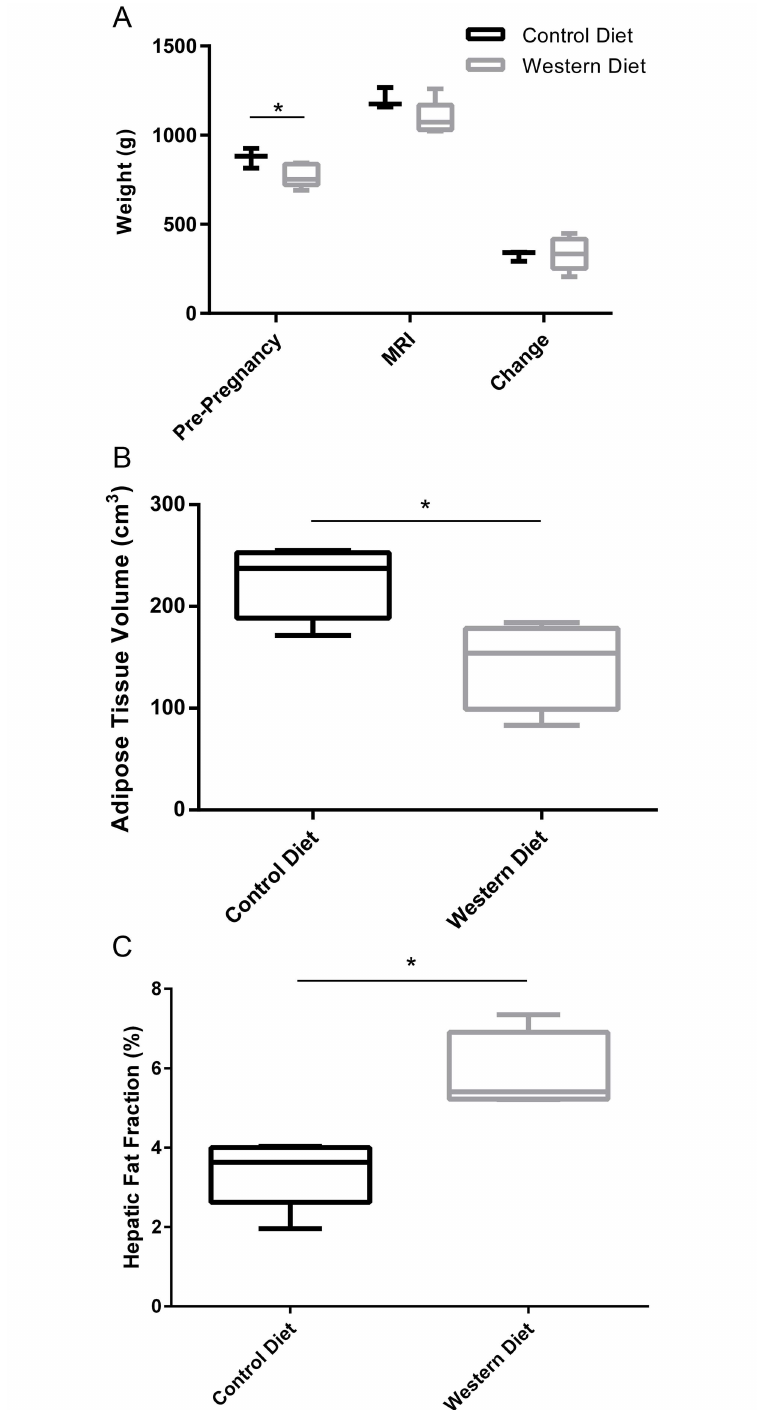
Fig 3. Weight and fat deposition measurements for Control Diet and Western Diet sows. (A) Weight measurements taken before pregnancy, on the MR scan date, and weight change during pregnancy (CD: n = 4; WD: n = 4). (B) Total adipose tissue volumes (CD: n = 4; WD: n = 4). (C) Hepatic proton density fat fraction (CD: n = 4; WD: n = 4). Data are presented as box and whisker plots as described in the methods section for CD (black) and WD (grey) sows. (cid:3) P <